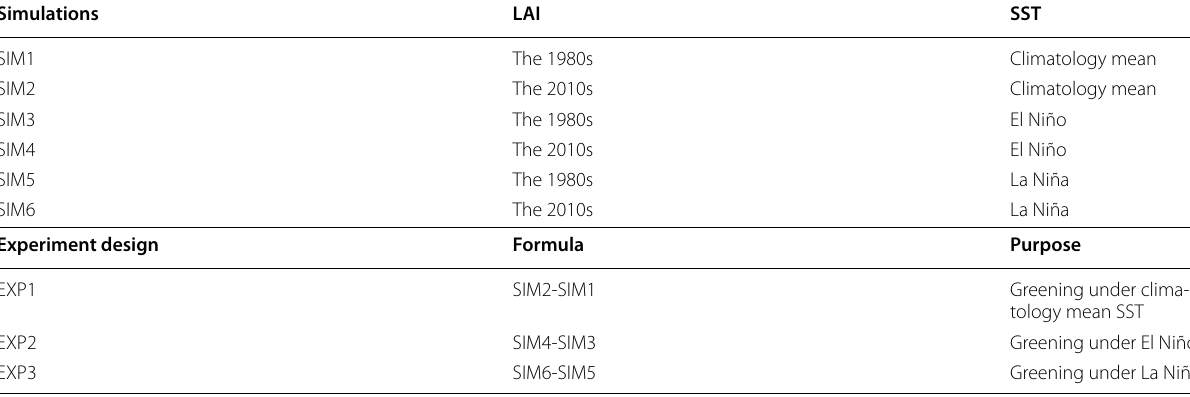
The difference between SIM2 and SIM1 (SIM2–SIM1) is used to identify the greening under climatology mean SST. SIM4–SIM3 indicates the greening under El Niño and SIM6–SIM5 refers to greening under La Niña